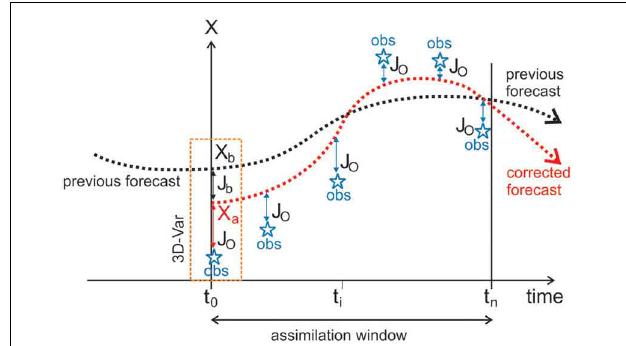
FIGURE 3 | Schematic diagram illustrating 4D-Var. Over the period of the assimilation window indicated 4D-Var is performed to assimilate the most recent observations (marked as blue stars), using a segment of the previous forecast as the background (black line—the background state x b is the initial condition). This updates the initial model trajectory for the subsequent forecast (red line), using the analysis x a as the initial condition. The box to the left identifies the special case of 3D-Var. Similar material can be found in http://www.ecmwf.int.